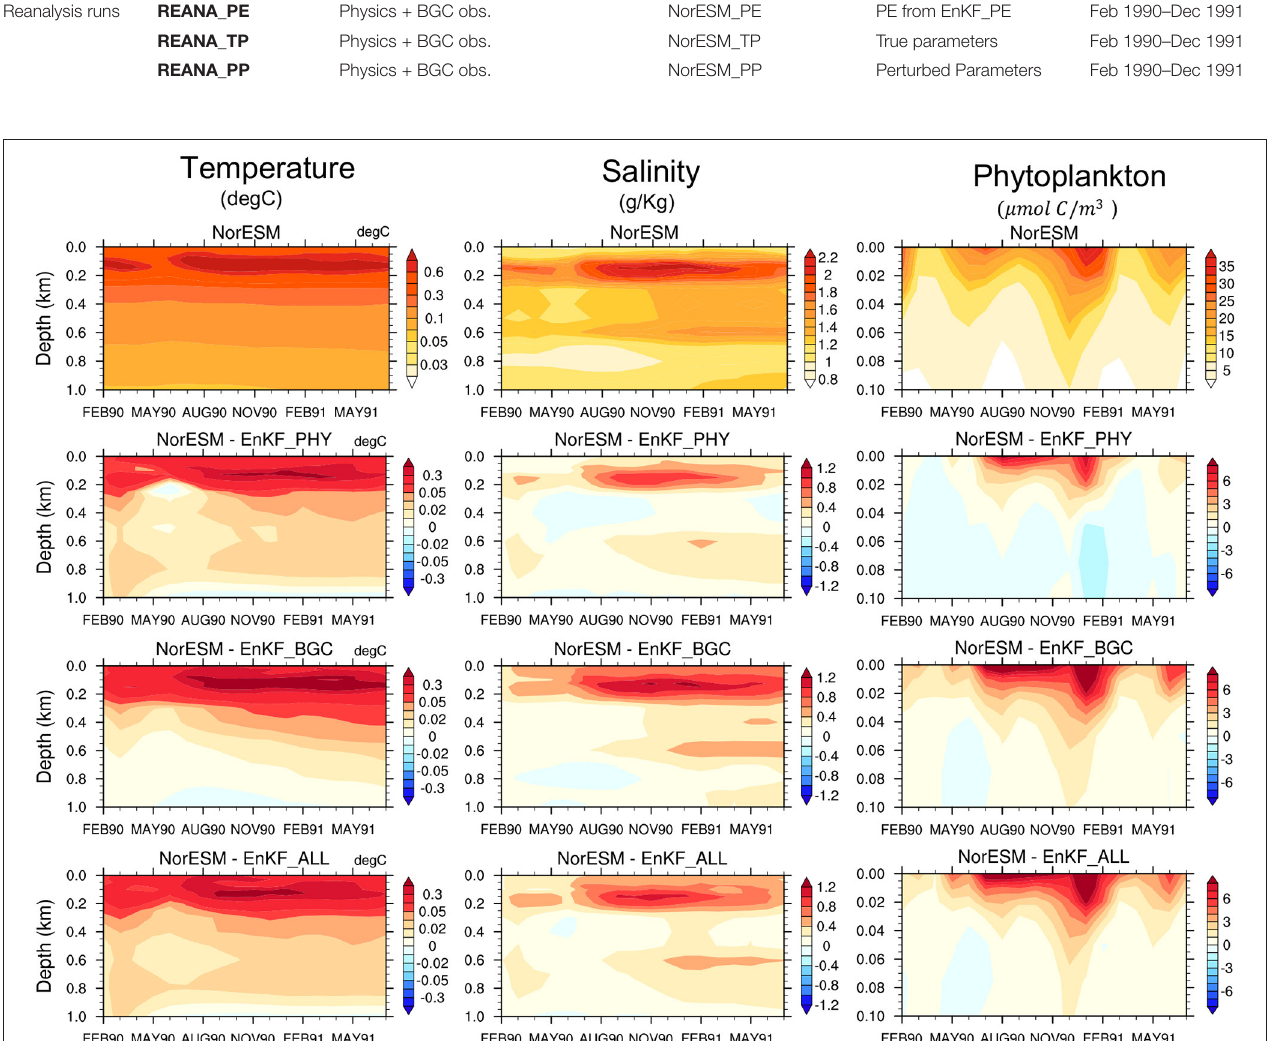
FIGURE 2 | The first row shows the time evolution of the vertical global-averaged RMSE for temperature (first column), salinity (second column), and phytoplankton concentration (third column) in the NorESM free run against TRUTH. The other rows show the RMSE difference (RMSED) for the same variables with assimilation of physics observation (EnKF_PHY), BGC surface observations (EnKF_BGC), and combined observations (EnKF_ALL), respectively. RMSED is computed by subtracting the RMSE of simulations with DA from that of free run RMSE. Warm (cold) colors represent improvement (degradation) from assimilation.